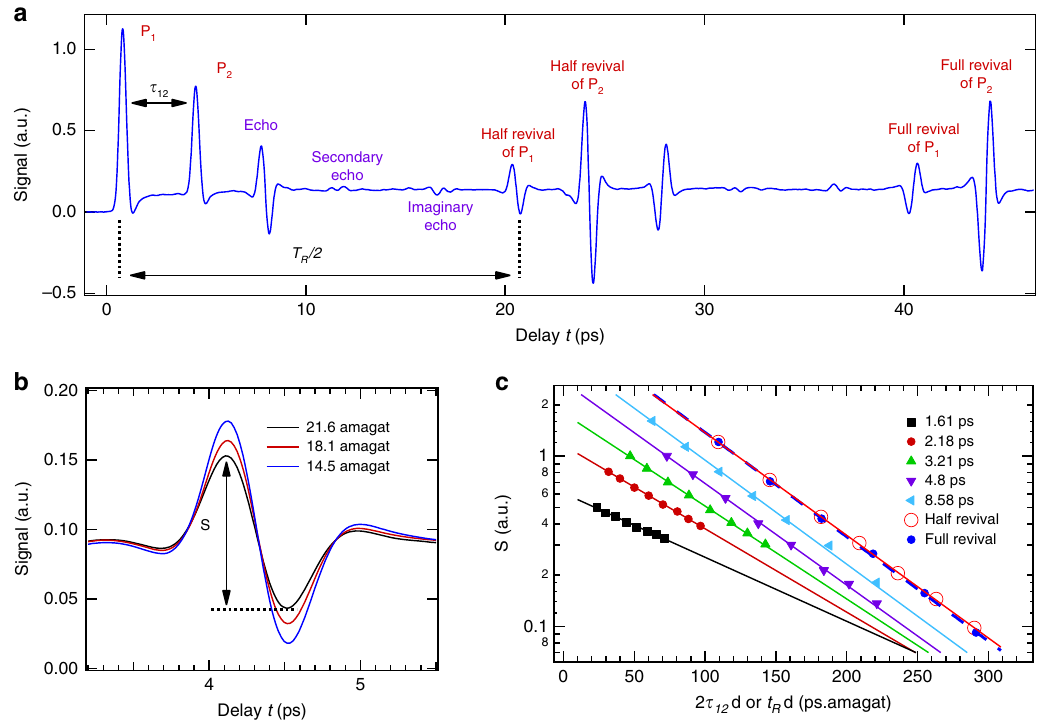
Fig. 2 Rotational structures of N 2 O aligned by two laser kicks. a Alignment signal recorded in pure N 2 O gas at low pressure by scanning the temporal delay between the fi rst aligning pulse P 1 (at t = 0) and the probe pulse over slightly more than the full rotational period T R = 40.4 ps of the molecule. The peaks identi fi ed by P 1 and P 2 correspond to the transient alignment signals produced by the two pulses separated by the delay τ 12 . The main echo is generated at t = 2 τ 12 , with the secondary echo observable at t = 3 τ 12 , and the imaginary echo produced at T R /2- τ 12 (equivalent features also appearing at times shifted by + T R /2). In addition to echoes, other transients corresponding to the standard half and full alignment revivals of P 1 (at T R /2 and T R ) and P 2 (at T R /2 + τ 12 and T R + τ 12 ) are also observed. b Alignment traces of N 2 O diluted in He measured at various densities around the main echo at 2 τ 12 for τ = 2.18 ps. The amplitudes S of the alignment structures are measured from peak to dip. c Amplitudes of the half revival (open red circles), full revival 12 (full blue circles), and of the main echo for fi ve different values of the delay τ 12 versus the gas density d multiplied by the time of observation t R ( T R /2 or T R ) and 2 τ 12 for the revivals and echo, respectively, expressed in picosecond amagat (ps.amagat, with 1 amagat = 2.687 × 10 25 mol. m − 3 ) units. The lines indicate the best exponential fi